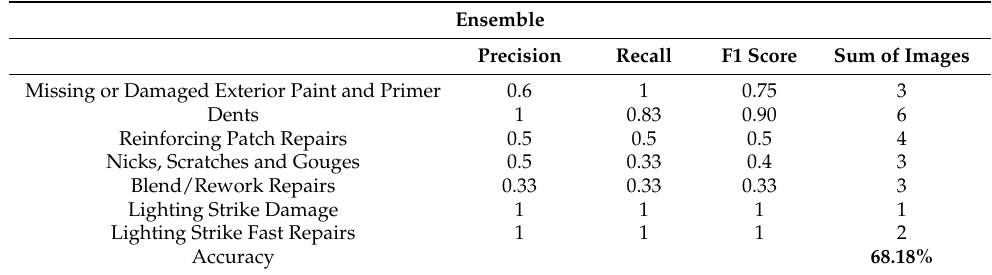
Table 17. Classification report of the ensemble model for defect classification.